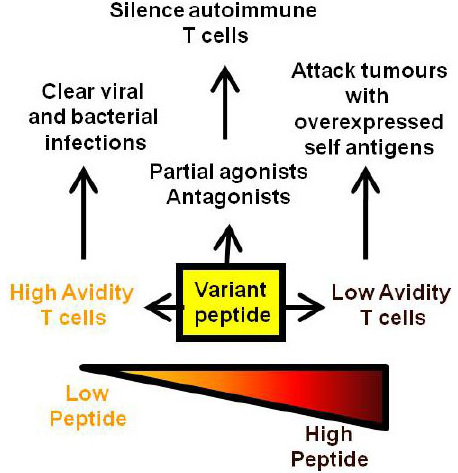
Figure 1. Summary of the effects of variant, low and high dose peptide on effector T cell